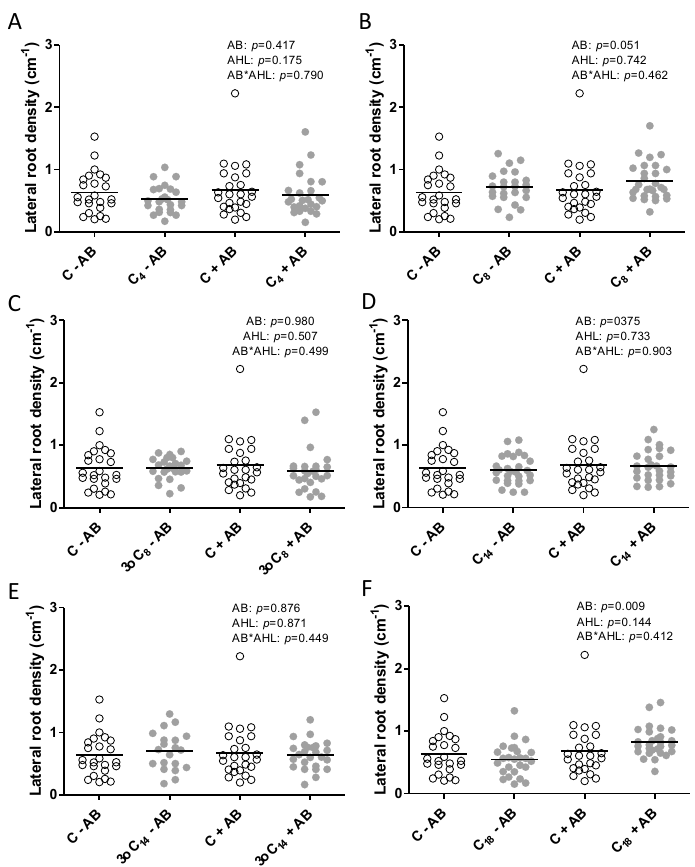
Figure 4. Lateral root density (number of primary lateral roots / cm main root length) of M. truncatula plants exposed to 1 μ M AHLs and inoculated with rhizobia, measured at 21 days after inoculation. Plants were treated with (grey) or without (white) ( A ) C 4 -HSL, ( B ) C 8 -HSL, ( C ) 3-oxo-C 8 -HSL, ( D ) C 14 -HSL, ( E ) 3-oxo-C 14 -HSL, or ( F ) C 18 -HSL. The control treatments (‘C’) included the same dilution of the solvent as the AHL treatments. Different letters indicate significant differences between the treatments when the interaction is significant (REML test p < 0.05). No post hoc test when the interaction is not significant. AB: antibiotic treatment.